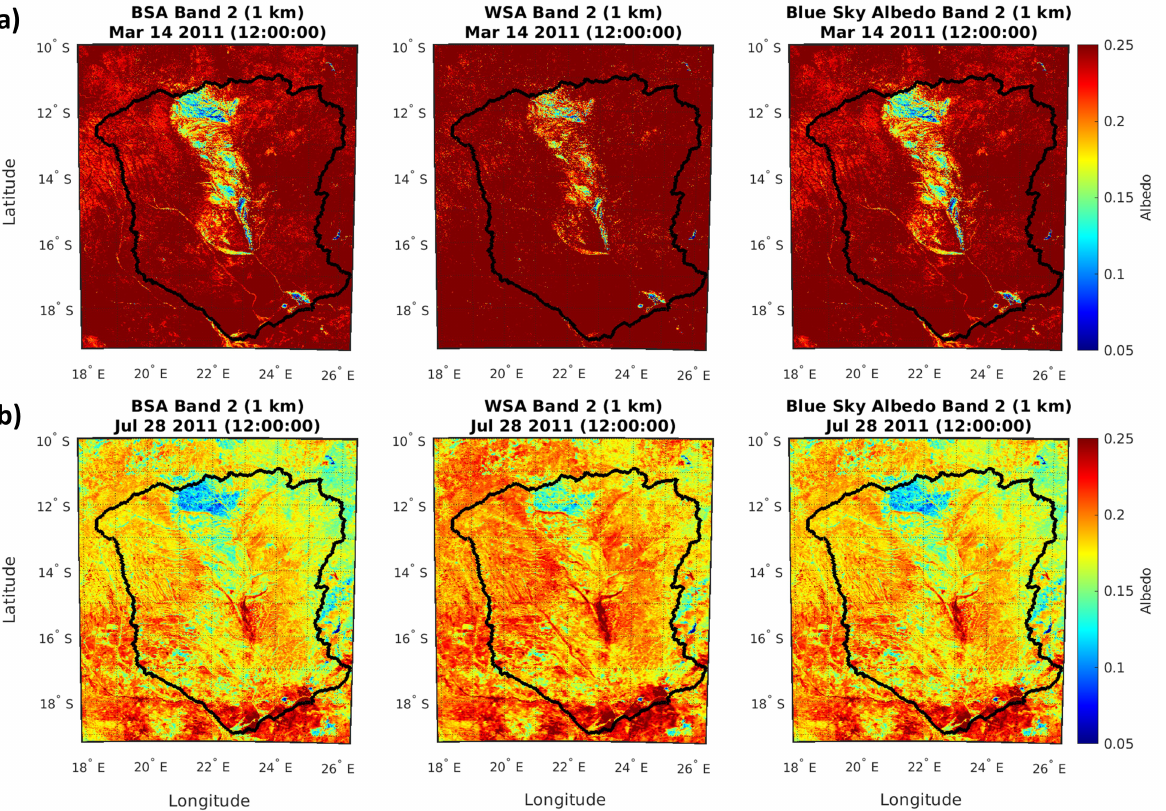
Figure 12. Example of Black-Sky Albedo (BSA), White-Sky Albedo (WSA), and blue-sky spectral albedo comparisons between dates in ( a ) the rainy season (14 March 2011) and ( b ) the dry season (28 July 2011) at noon local